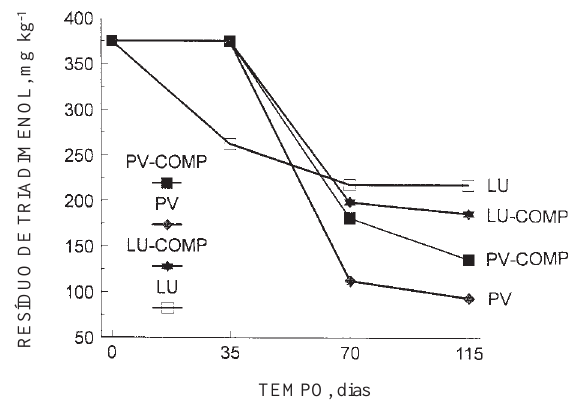
Figura 1. Concentração de resíduos de triadimenol, mg kg -1 , detectados ao longo do